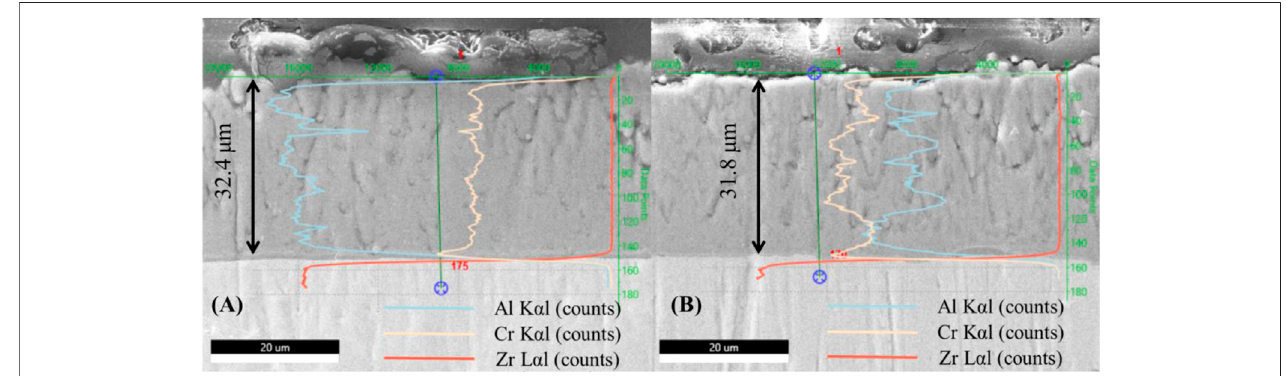
FIGURE 10 | EDS results of cross-section of each ATF candidate cladding with 6 h deposition: (A) Cr 32.1 Al 67.9 , (B) Cr 45.8 Al 54.2 .